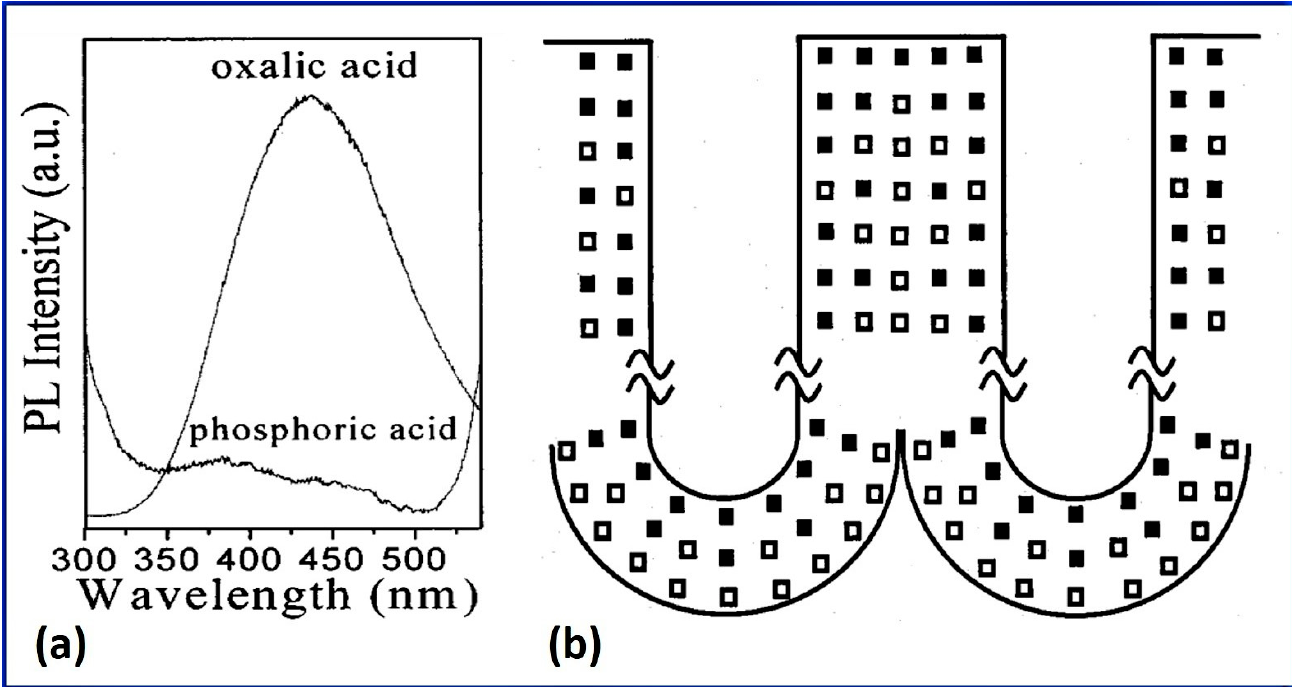
Figure 10. ( a ) The PL spectra of NAA prepared in oxalic and phosphoric acid, and ( b ) a typical distribution of F (black squares) and F+ centers (open squares) in NAA. Reprinted with permission from GS Huang, XL Wu, YF Mei, XF Shao, and GG Siu, Journal of applied physics 93 (1), 582 (2003). Copyright 2003 AIP [85] .